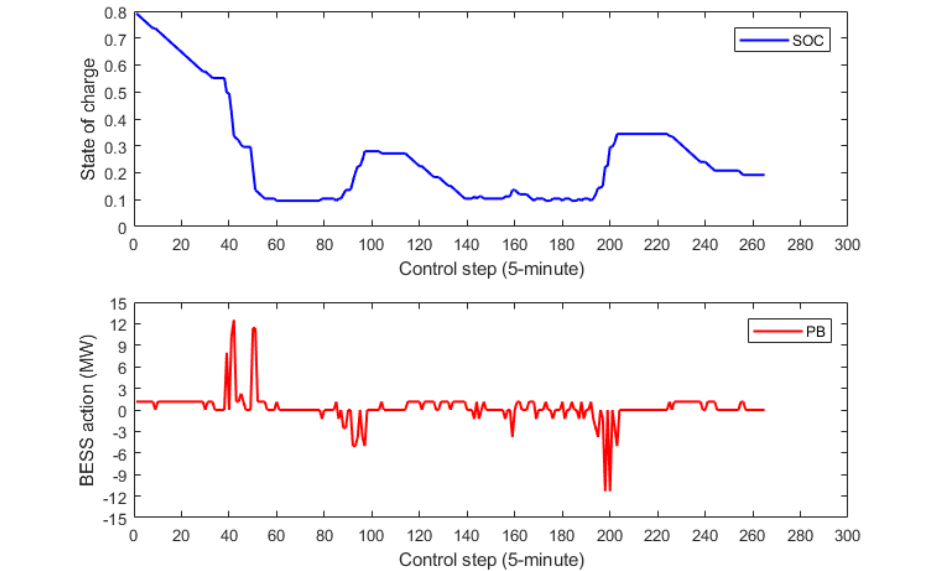
Figure 8. Battery energy storage system (BESS) actions and SOC (higher demand).